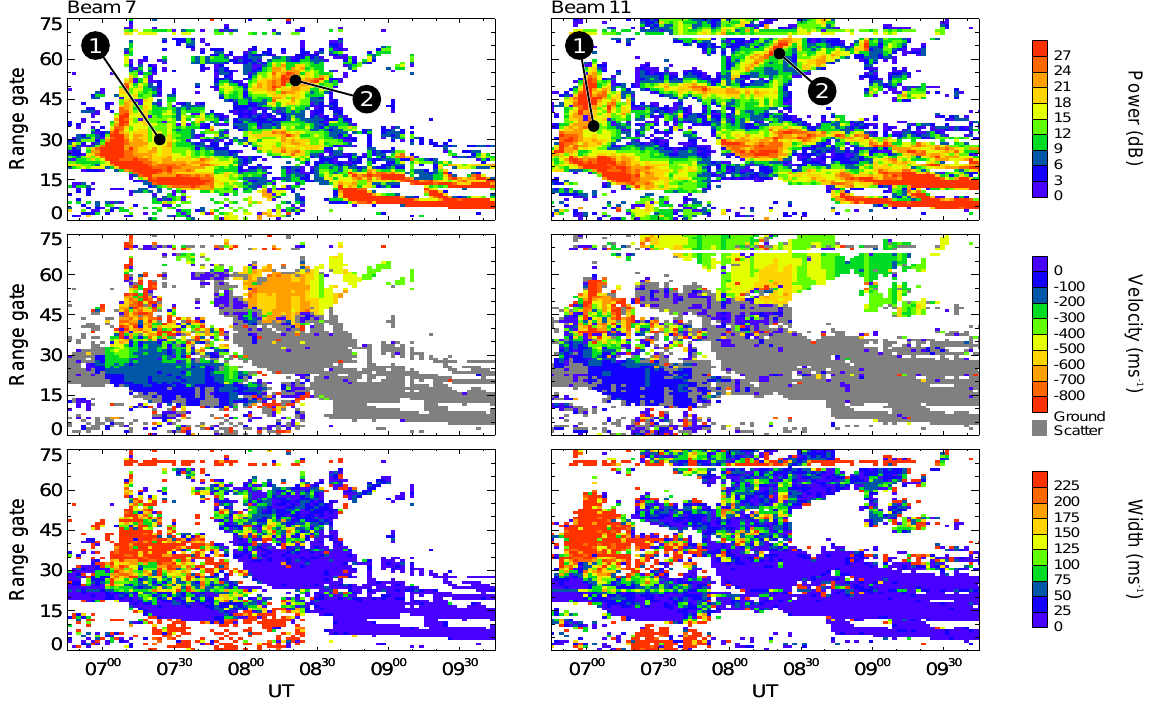
Fig. 3. Observations from beam 7 (left-hand panels) and beam 11 (right-hand panels) of the CUTLASS Finland radar from 06:45 to 09:45UT on 23 November 1999. For each beam, backscattered power (upper panel), line-of-sight irregularity drift velocity (central panel) and spectral width (lower panel) are presented as a function of range gate; positive drift velocities are those directed towards the